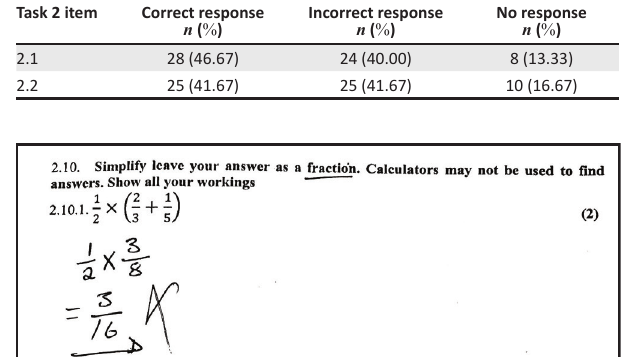
TABLE 2: Total number of participants’ responses to Task 2. Task 2